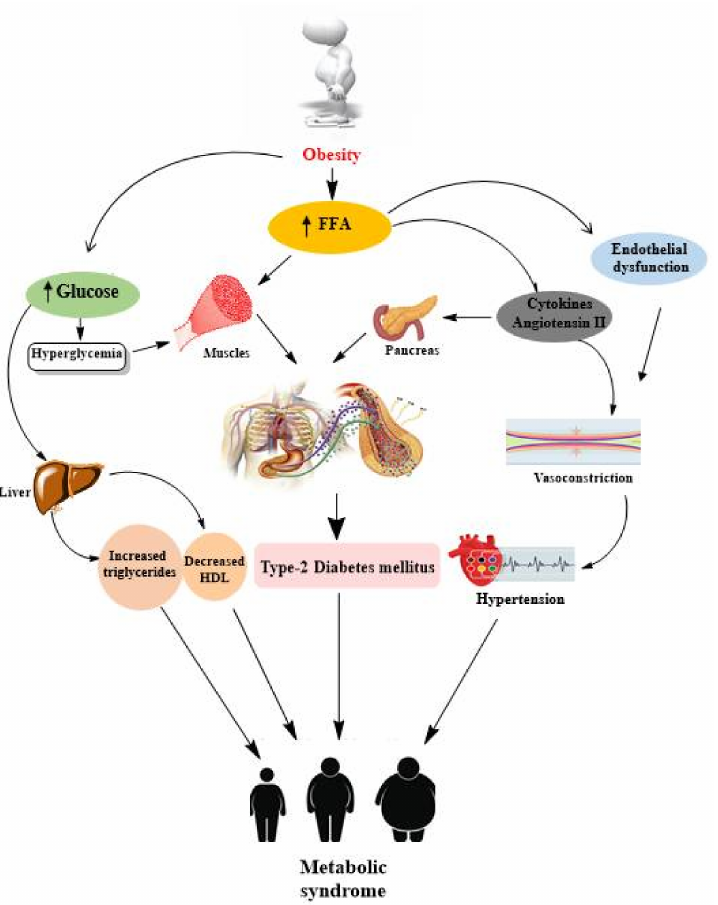
Figure 3. Pathophysiology of metabolic syndrome. Obesity, hypertension and insulin resistance are the major contributing factors in metabolic syndrome. FFA: free fatty acids; high-density lipoprotein (HDL)